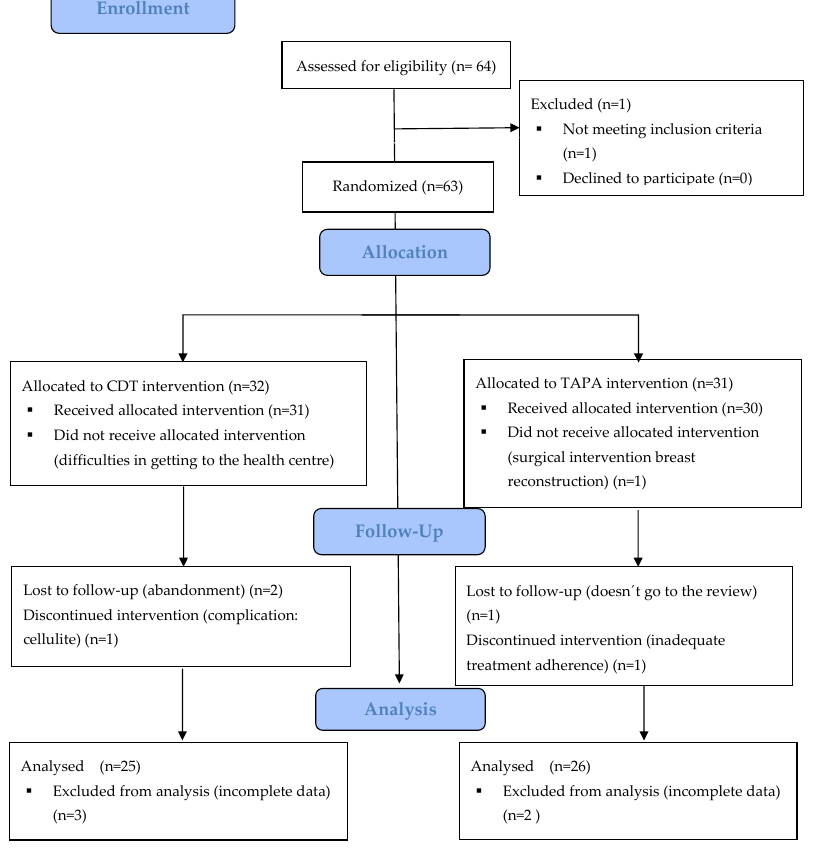
Figure 1. Flowchart. CDT: Complex decongestive physical therapy; TAPA: activity-oriented proprioceptive antiedema therapy.